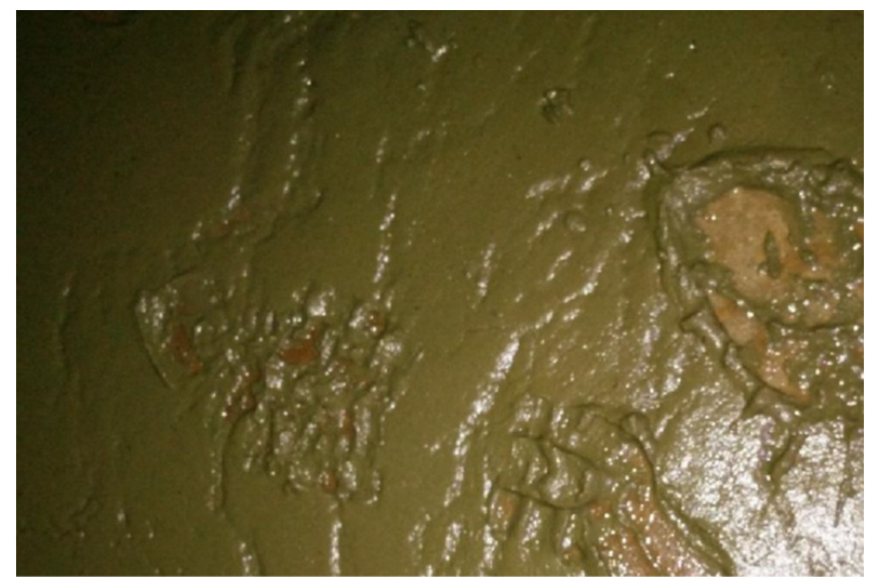
Figure 8. Sediments in an inverted siphon.